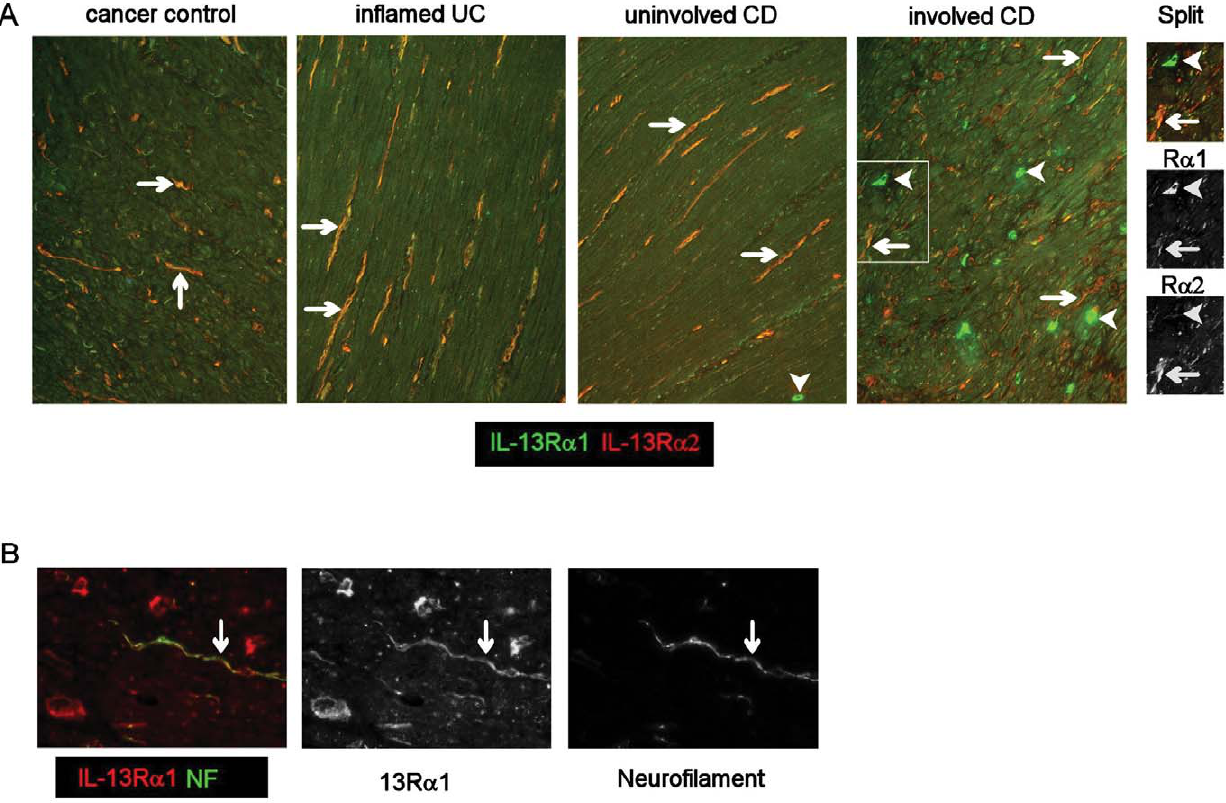
Figure 4. IL-13 receptors are expressed on smooth muscle cells and neurofilaments in CD strictures. Frozen sections were processed for double immunoflorescence. (Panel A) double labeling for IL-13 R a 1 and R a 2 in intestinal muscle tissue, arrows show double-stained cells, arrowheads show cells expressing R a 1 only at a very high level. Boxed area is shown as the colour image and its monochrome split. (B) Co-staining of IL-13R a 1 and neurofilament (NF) (green) and the monochrome split images. A,B, 6 20 images.